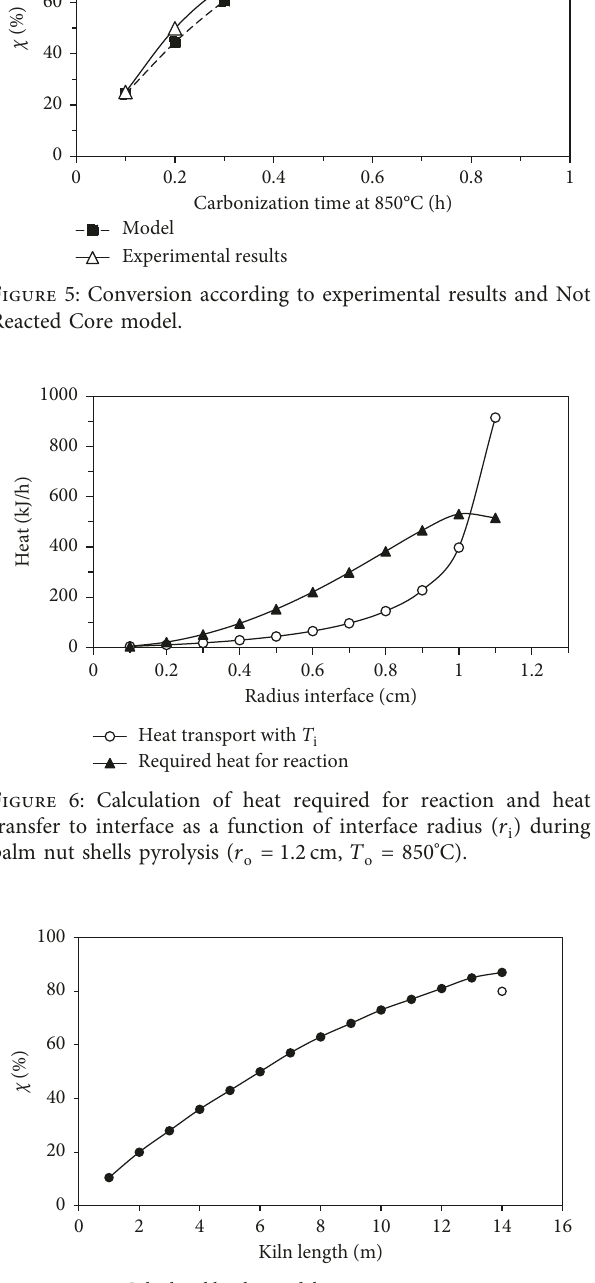
12 mm; feed 900 kg/h; T 850 ° C; n (cid:27) (cid:27) (cid:27) (cid:27)